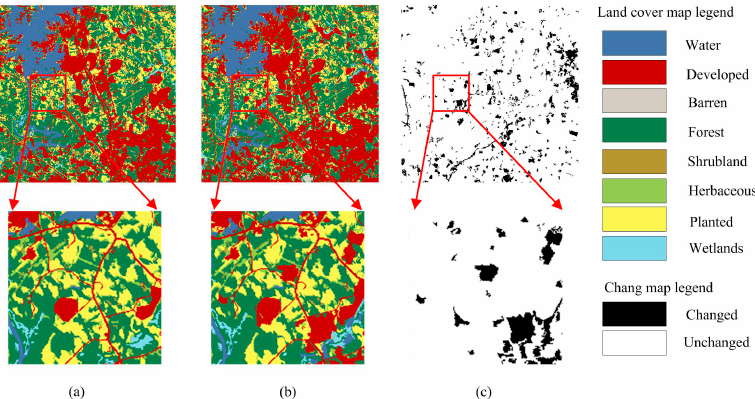
Figure 4. National Land Cover Database (NLCD) land cover maps and the corresponding change maps